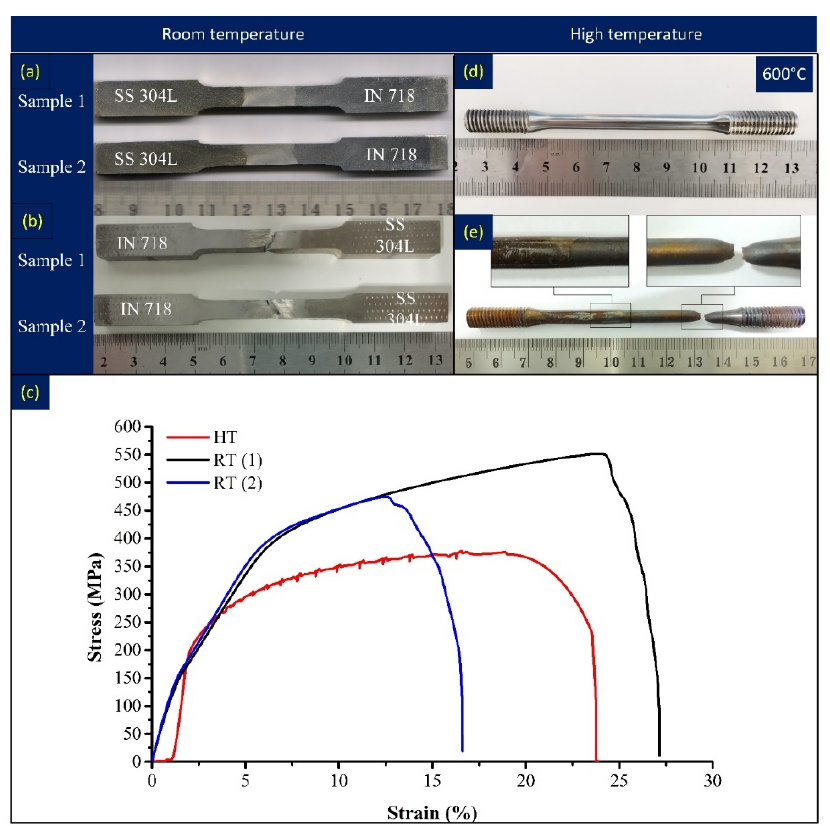
Figure 10. ( a ) Specimen before fracture, ( b ) after fracture, ( c ) stress–strain plot of welded joint, ( d ) high-temperature tensile specimen before fracture, ( e ) after fracture. Table 2. Tensile test results of test coupons tested at room temperature and high temperature.